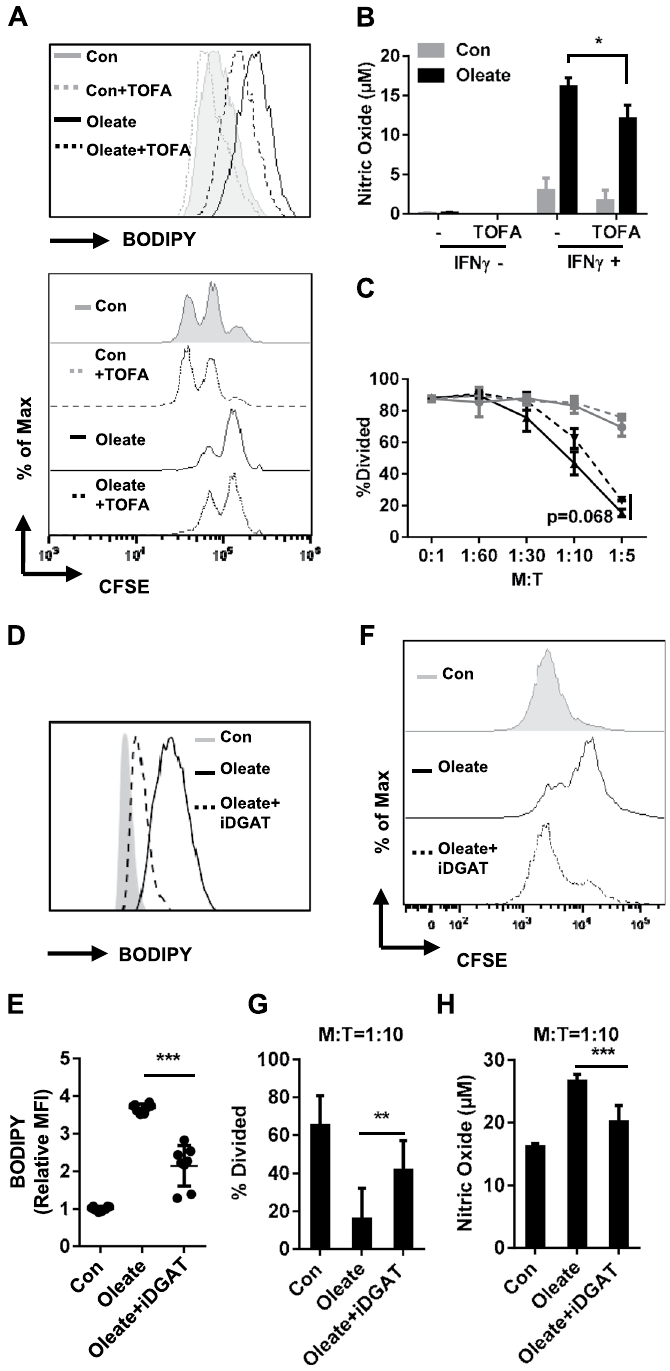
Figure 5. Diglyceride acyltransferase (DGAT) dependent lipid droplets formation controls the effect of sodium oleate on MSC-2 cells. MSC-2 cells were incubated with TOFA (5 µ g/ml) in the presence or absence of sodium oleate (0.2 mM). Droplets formation was evaluated by BODIPY staining and flow cytometry ( A ). MSC-2 cells were incubated in the presence or absence of sodium oleate and TOFA as indicated and were subsequently stimulated with IFN γ (1 ng/ml) for 24 h. NO production was determined ( B ). MSC-2 cells were co-cultured with CD4 + T cells in the ratios as indicated and in the presence or absence of TOFA (5 µ g/ml). Cell proliferation was evaluated by CFSE staining after 72 h ( C ). Combination of DGAT inhibitors was added together with sodium oleate for 24 h, the lipid droplets formation was analyzed via BODIPY staining ( D , E ). Functional assay was also performed in the co-culture system with CD4 + T cells: the proliferation of T cells ( F , G ) and the production of NO in the co-culture wells ( H ) were measured. Shown is the mean ± SD from two to four independent experiments. * p < 0.05; ** p < 0.01; *** p <